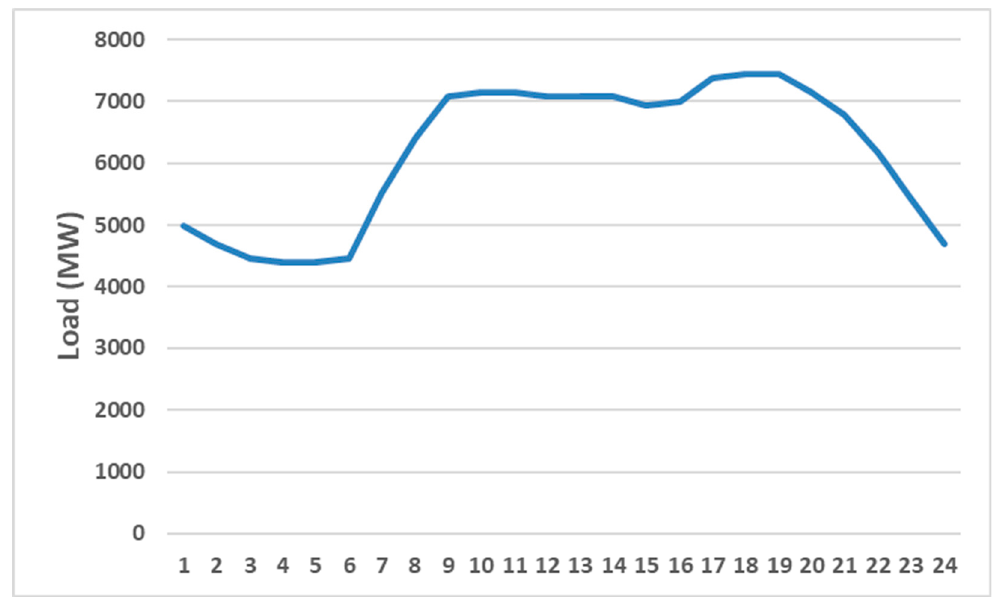
Figure 5. Evolution of hourly demand of the examined typical day. 360